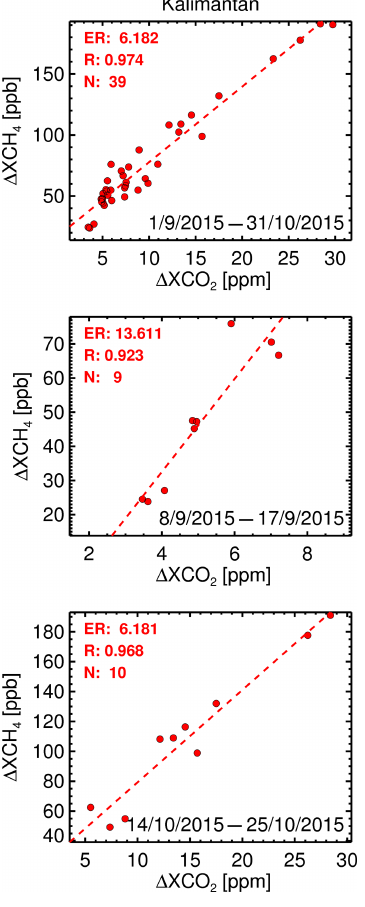
Figure 10. Scatterplots of (cid:49) XCH 4 vs. (cid:49) XCO 2 derived for Kali- mantan large-scale fire plumes via analysis of TANSO-FTS data for the time periods detailed in Fig. 8: September–October 2015 (top), Period 1: 8–17 September (middle) and Period 2: 14–25 October (bottom). The CH 4 / CO 2 ER is calculated as the gradient of a lin- ear fit to the data (dashed line). The correlation coefficient R and the number of soundings N are also